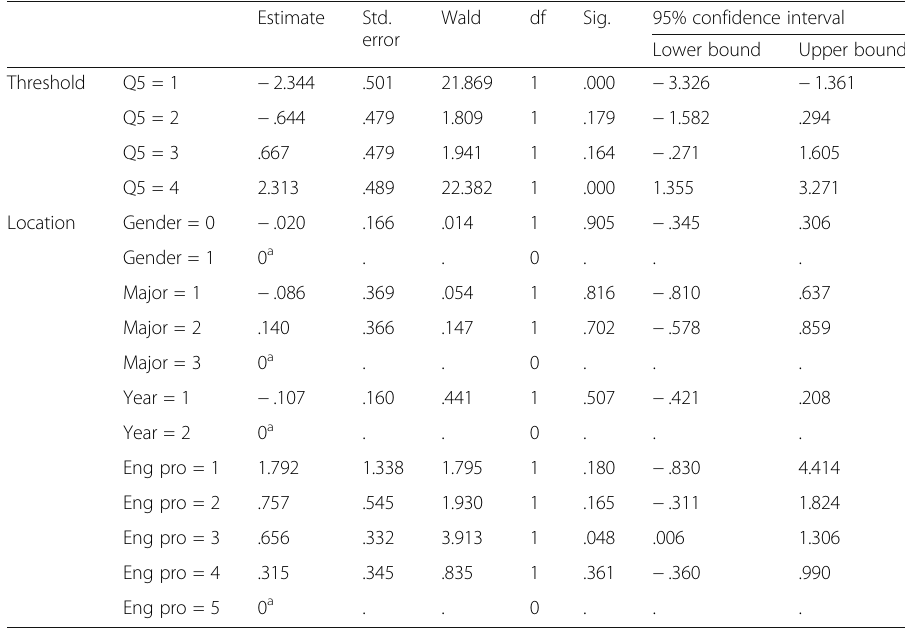
Table 11 Factors influencing students ’ English learning approaches